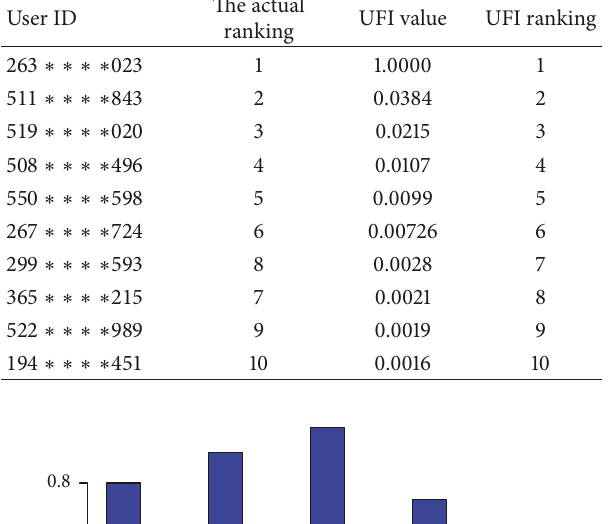
Table 10: Comparison of user actual ranking with UFI ranking.